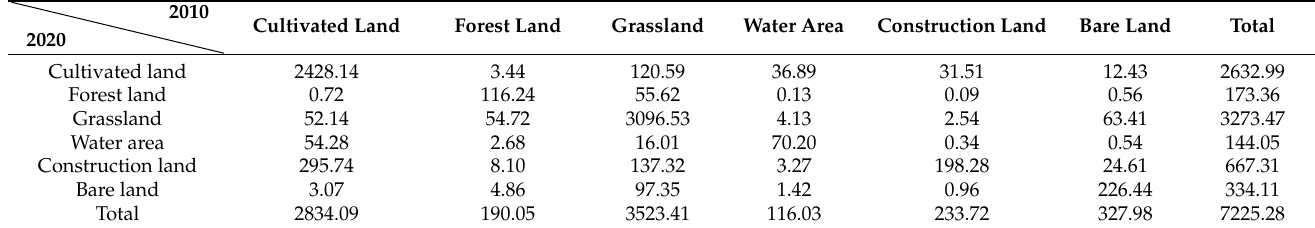
Table 9. The land use transfer matrix in Yinchuan from 2010 to 2020 (unit: km 2 ).